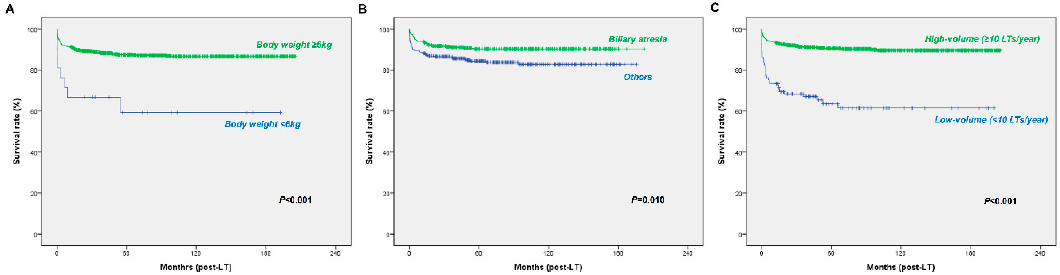
Figure 3. Kaplan–Meier analysis of survival using the KONOS and KOTRY databases. ( A ) Patient survival, ( B ) graft survival.